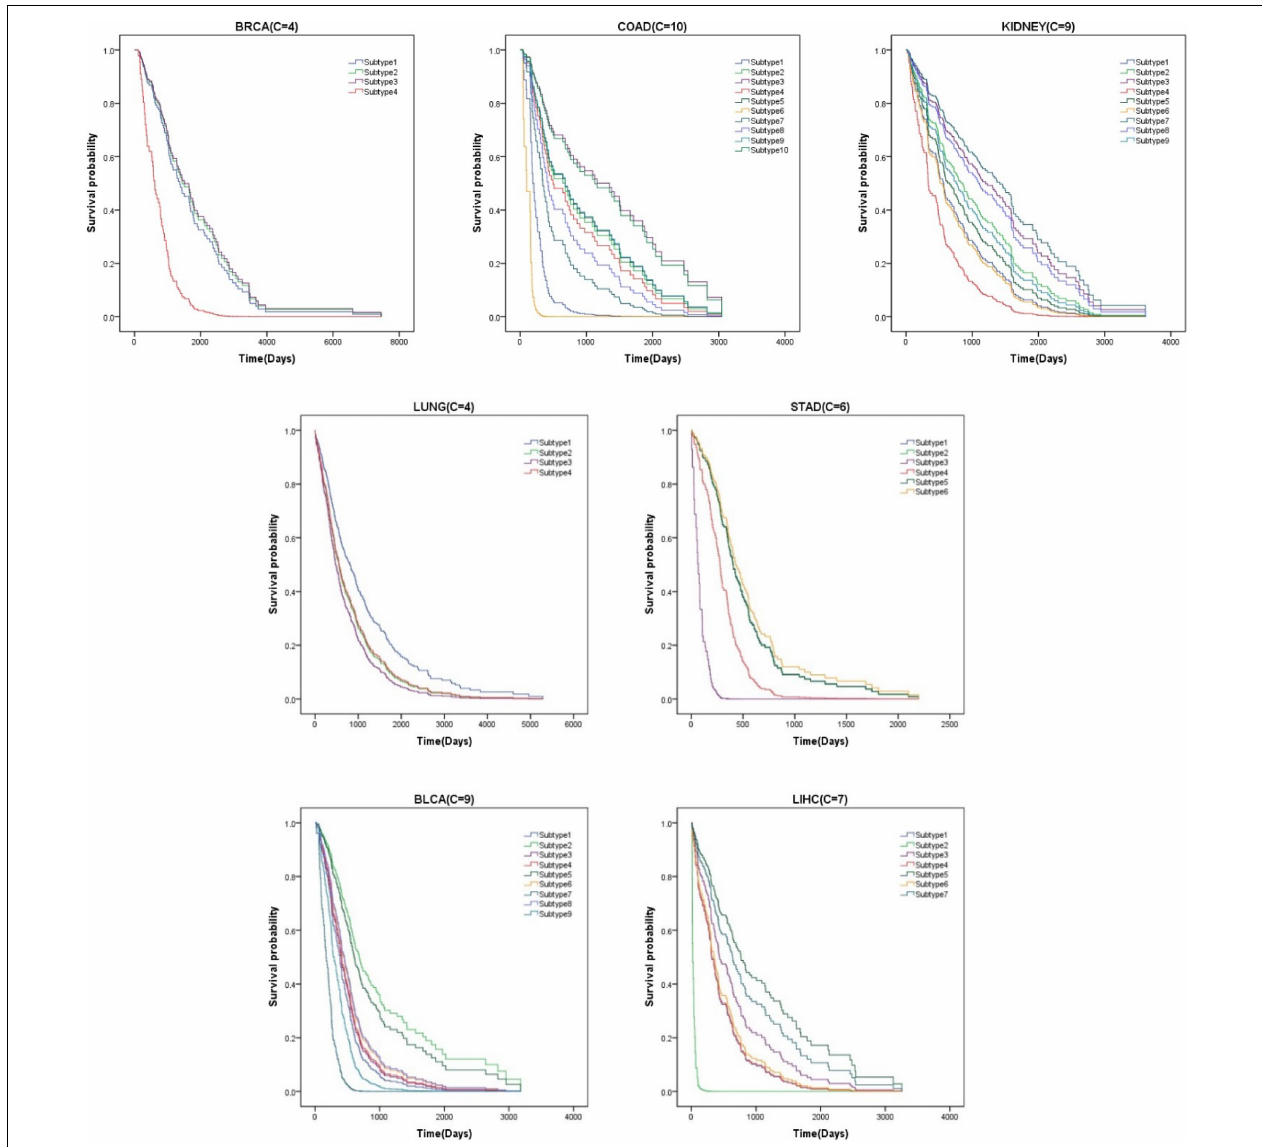
FIGURE 2 | Survival curves of various subtypes for seven cancer